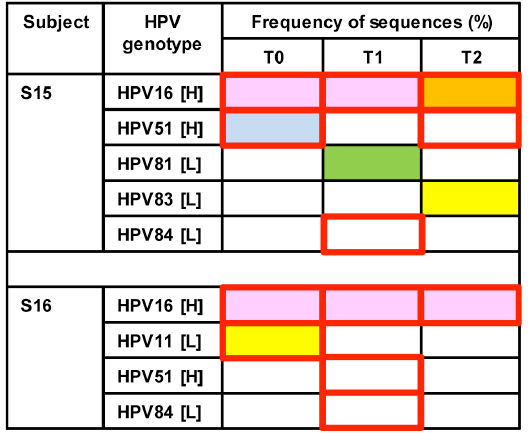
Figure 5. Longitudinal changes of HPV genotypes in two individuals. Each HPV genotype captured by deep sequencing within an individual is depicted as a color-­‐‑filled block: Pink represents HPV by deep sequencing within an individual is depicted as a color-filled block: Pink represents HPV type type defined by ≥95% of sequences; orange, sequences ≥50% but <95%; yellow, sequences ≥1% but defined by ě 95% of sequences; orange, sequences ě 50% but <95%; yellow, sequences ě 1% but <50%; <50%; green, sequences ≥0.1% but <1%; and blue, <0.1% sequences. Red-­‐‑outlined squares represent green, sequences ě 0.1% but <1%; and blue, <0.1% sequences. Red-outlined squares represent HPV types detected by LA. H: high-­‐‑risk; L: low-­‐‑risk.